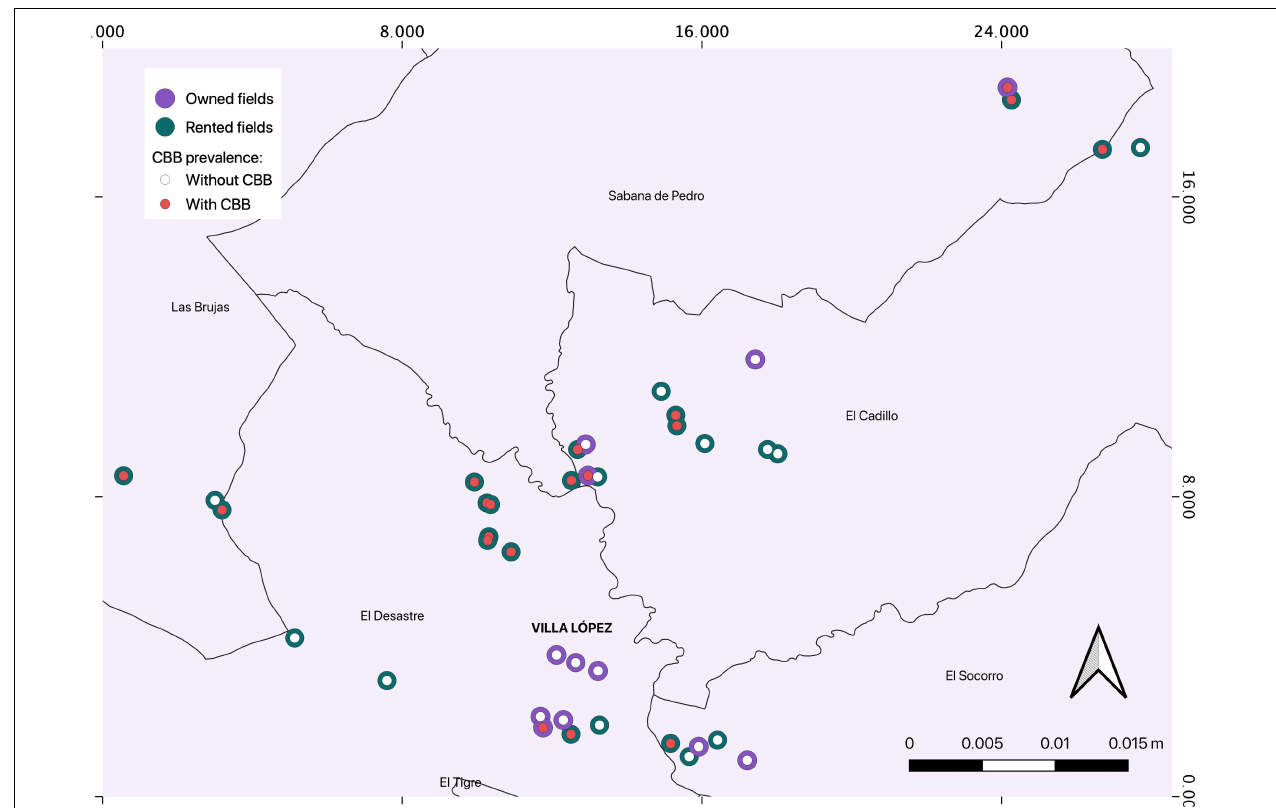
FIGURE 5 | Map of the distribution of Cassava Bacterial Blight occurrence as a function of land tenure. WGS